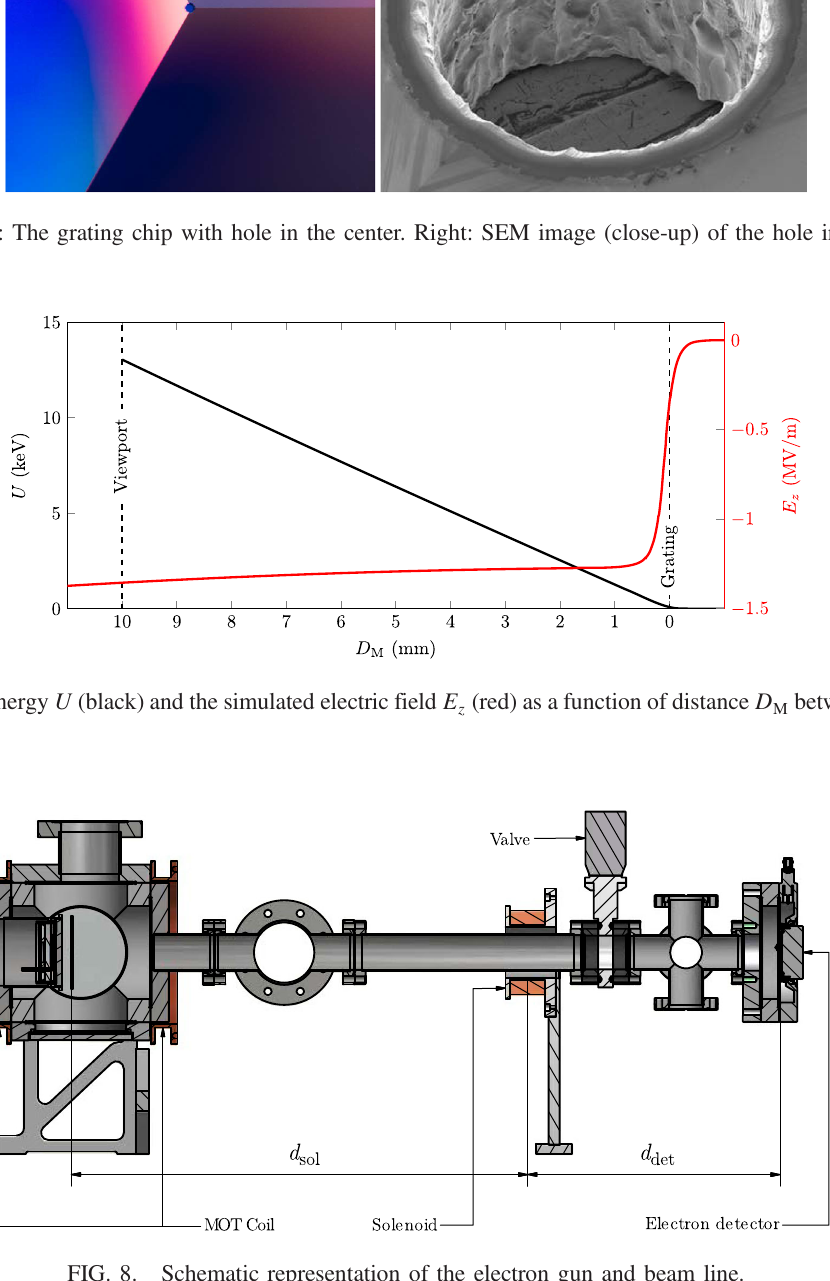
FIG. 8. Schematic representation of the electron gun and beam